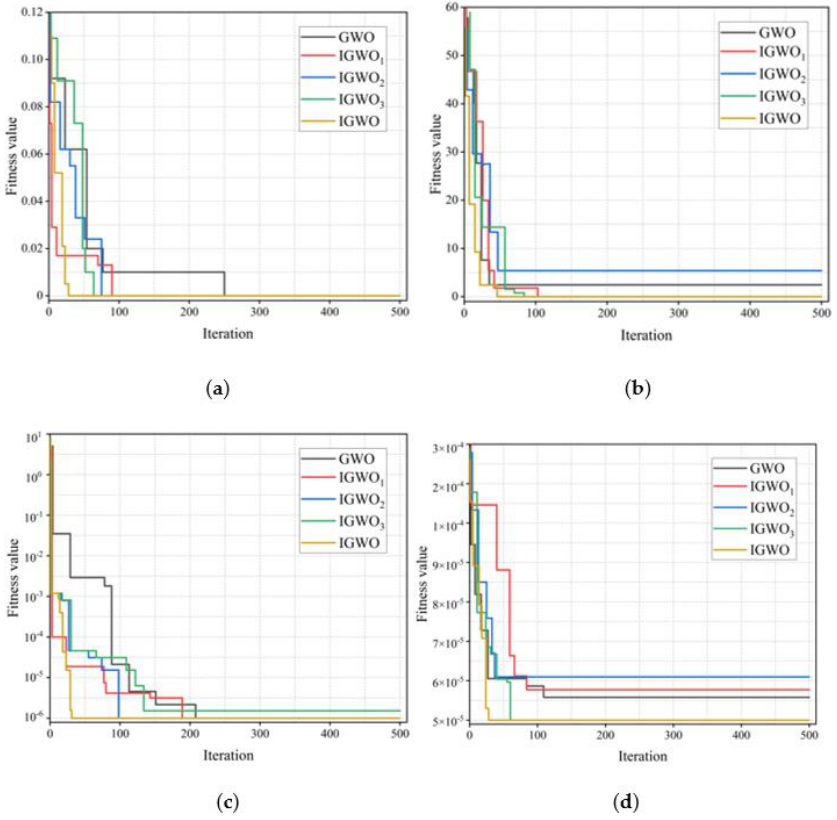
Figure 9. Different GWO algorithms converge on four standard test functions: ( a ) sphere function; ( b ) Rosenbrock function; ( c ) Schewfel function; ( d ) Rastrigin function.